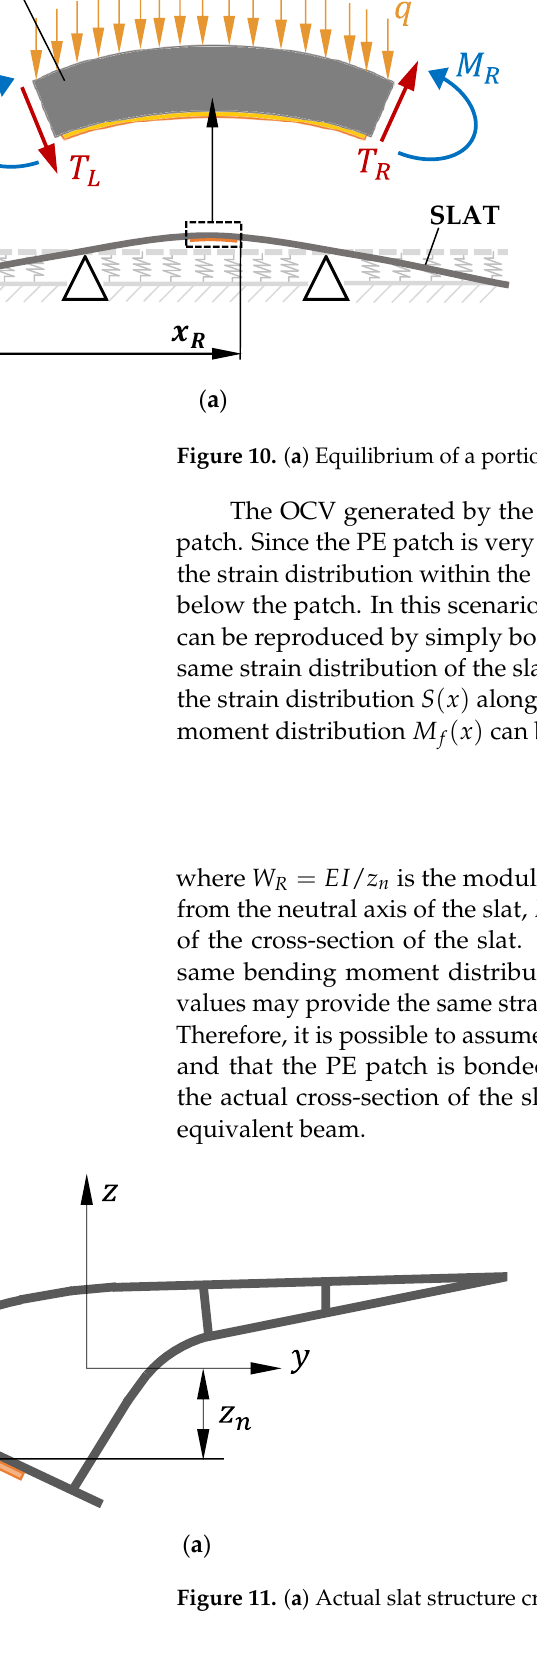
Figure 11. ( a ) Actual slat structure cross-section; ( b ) cross-section of the equivalent beam.